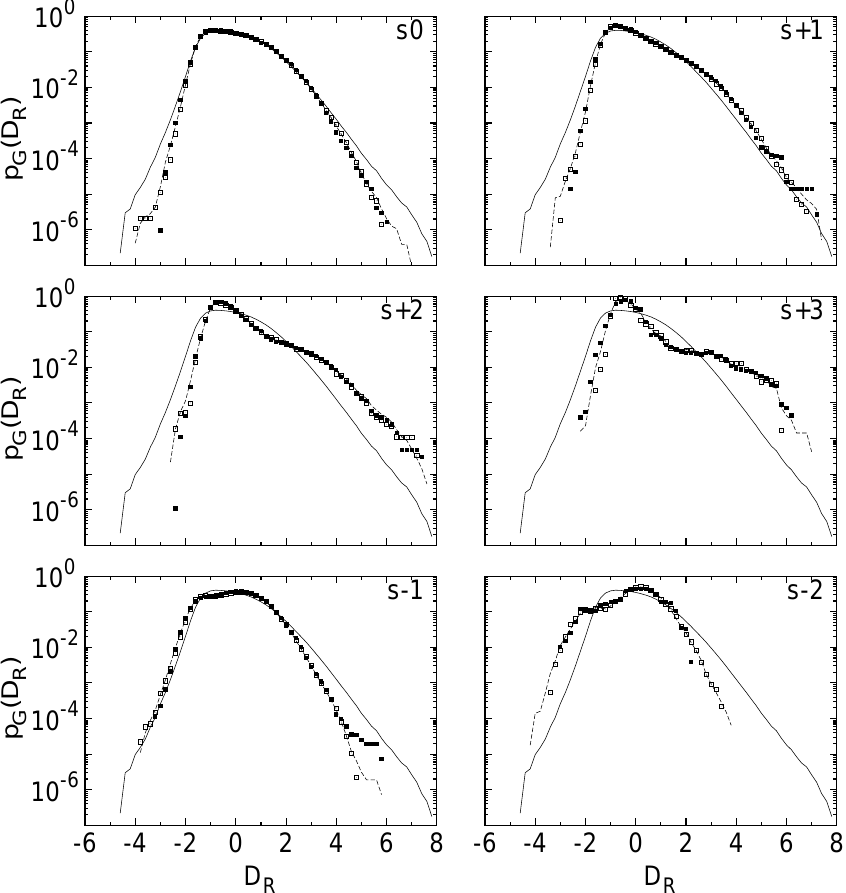
Fig. 3. The value of the probability density P G (D R ) for the skewness classes subsets obtained from the entire database (dashed line), the stratiform database (solid squares), and the convective database (open squares). The label on the top right corner of each panel indicates the skewness class: s0, s+1, s+2, s+3, s − 1, s − 2. The solid line denotes the probability density P G (D R ) for the entire Darwin database.